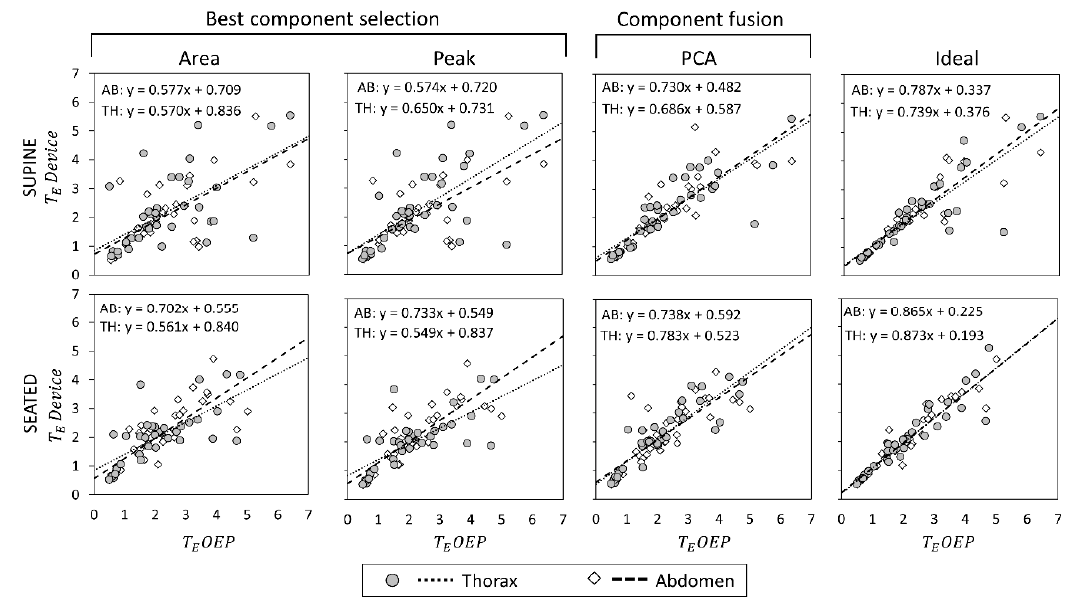
Figure 7. Comparisons of expiratory time (T E , expressed as seconds) measurements by using the proposed device and by using Optoelectronic plethysmography (OEP) presented as regression analysis, in supine (top panels) and seated (bottom panels) positions. Regarding T E measurements obtained with the IMU-device, three dimension-reduction methods were considered. Area, Peak and PCA-fusion. The performance obtained by using these three methods is benchmarked against that obtained with the Ideal quaternion component determined a posteriori based on the minimum estimation error. The regression line between measurements done by OEP and the proposed device is plotted, and the relative equation presented, both for the thorax and the abdomen. Table 3. Correlation outcomes across subjects and breathing patterns. Coefficient of correlation (r) between measurements obtained using Device vs. OEP are reported for f B . T I . and T E using best component-selection methods (“Area” and “Peak”), PCA-fusion method and “Ideal” component, in supine (Thorax: n = 37. Abdomen: n = 37) and seated (Thorax: n = 35. Abdomen: n = 39) position. Supine Seated Thorax Abdomen Thorax Abdomen Area 0.580 f B